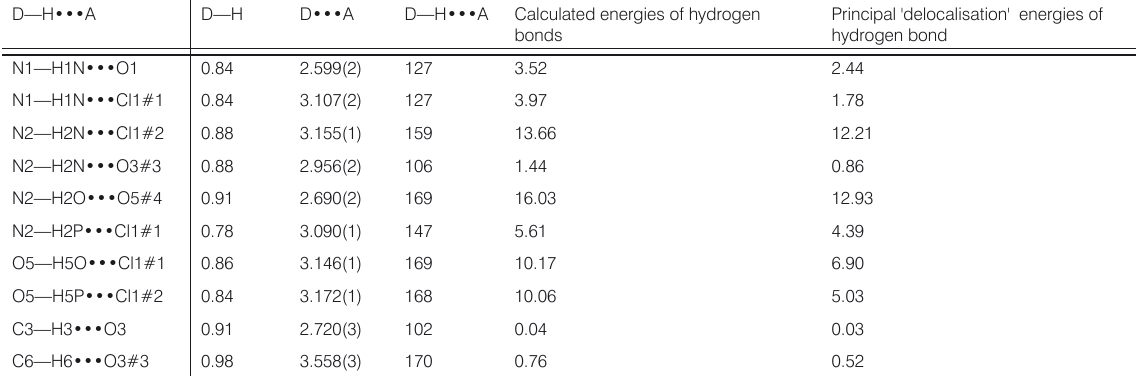
Table 3. Hydrogen bond geometry (experimental) [Å,°] and energy (calculated) [kcal mol -1 ] of (I).